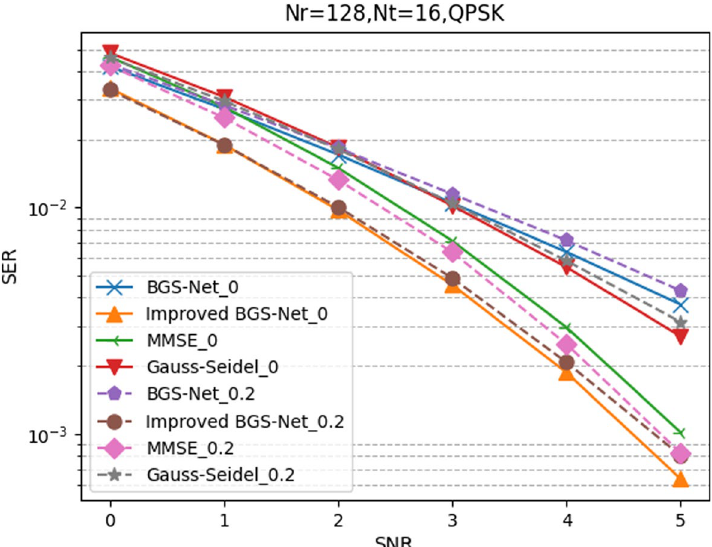
Fig. 26 SER performance comparison of different algorithms for N t = 16,N r = 128 , QPSK, MAUE system with ξ r = 0 or 0.2, ξ t =